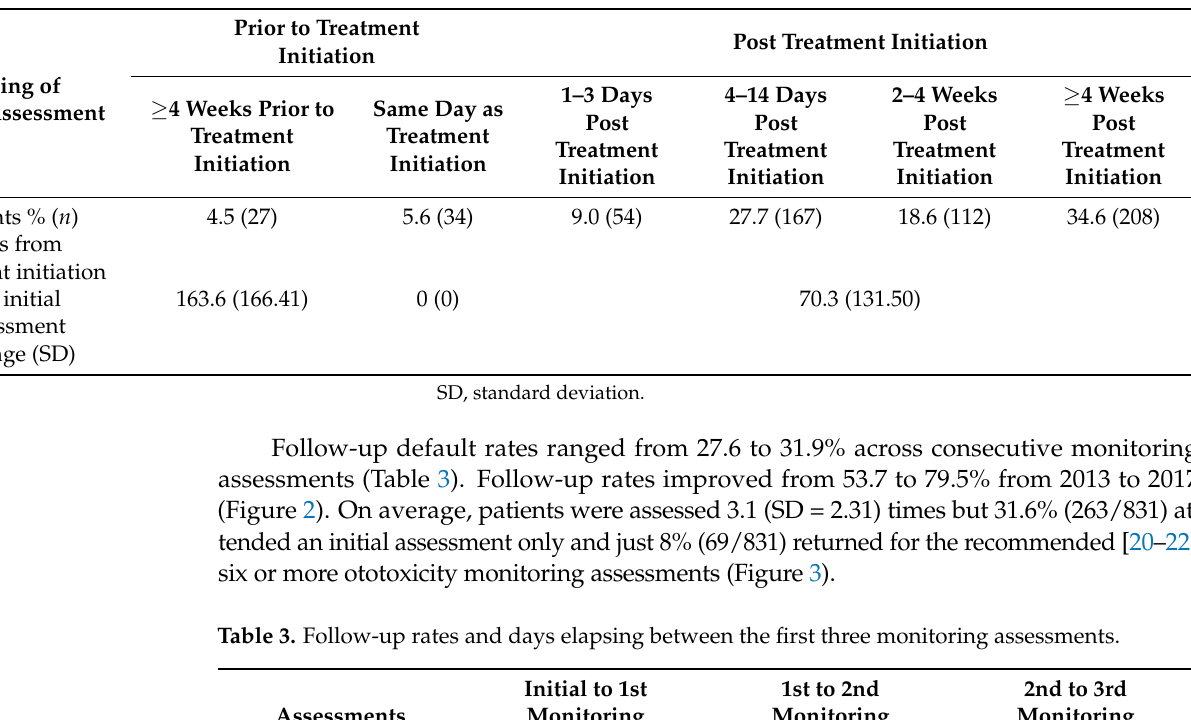
Table 2. Timing of initial assessment in relation to treatment initiation ( n = 602).